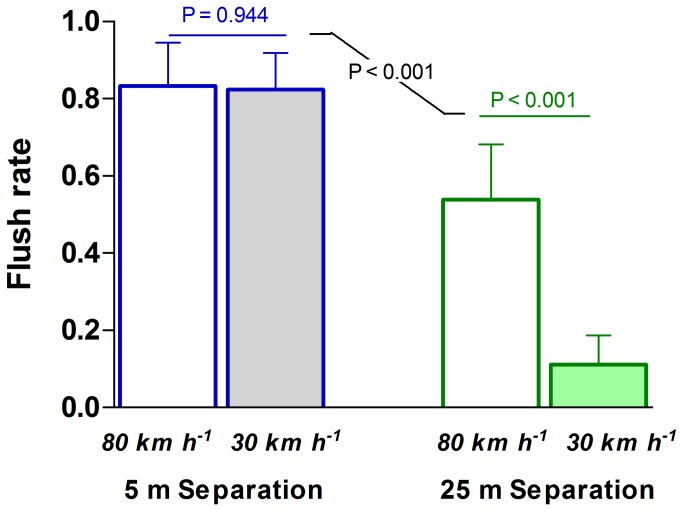
Effects of separation distance and vehicle speed on flush rate in crested terns during experimental encounters with vehicles on open-coast beaches.